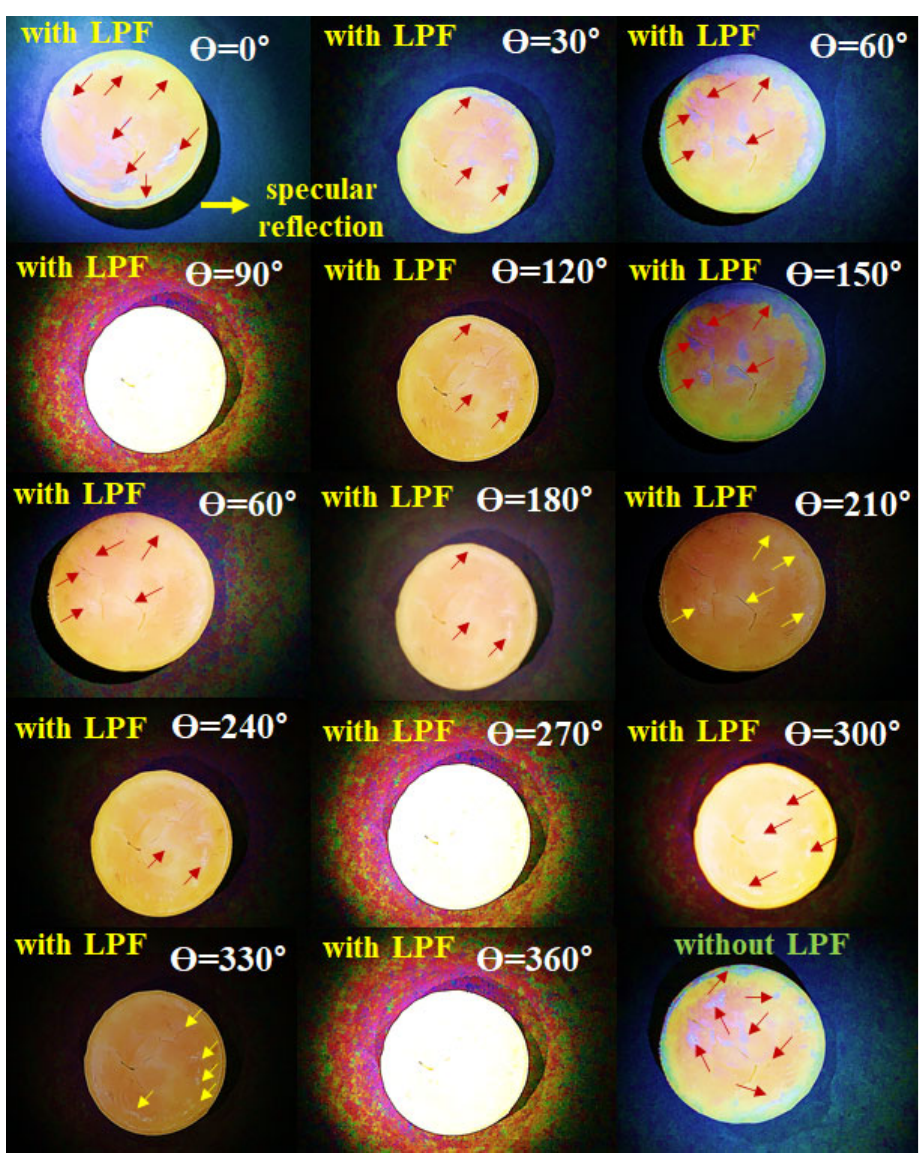
Figure 17. This study analyzes light reflection (diffuse reflection and special reflection) by LED irradiation and light reflection (diffuse reflection and special reflection) generated by chemical reaction of fluorescent contrast agents when irradiating LEDs and suggests a method to effectively remove such light reflection. When the LED is irradiated, the light without filter is strongly reflected in the center of the phantom, and the area around the phantom is diffuse reflection, as shown in Figure 17. At this time, if LPF 2 (Figure 15) is and its intensity is analyzed differently depending on the rotation angle ( θ ) for other re ‐ rotated (0 ◦ –180 ◦ ) in Figure 18, it can be seen that light reflection is suppressed (98.9%) when sults. To obtain reliable results, this imaging testing was performed three times (without the angle of rotation (LPF 2 ) is 90 ◦ as shown in Figure 18. LPF and with two different LPF), and were found to produce consistent results.